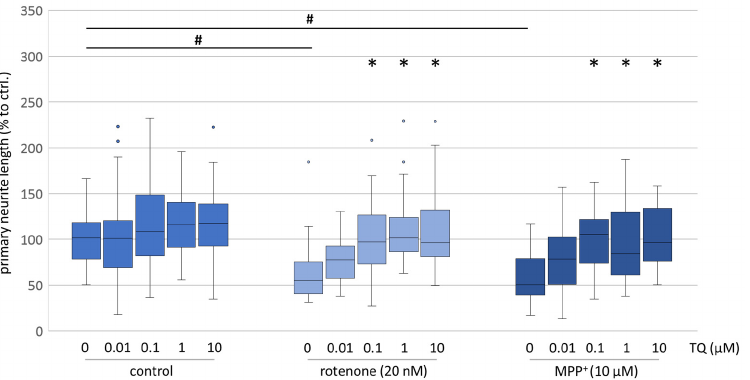
Figure 3. Effects of TQ on the length of the primary neurites of THir (dopaminergic) neurons in rotenone- or MPP + -affected primary mesencephalic cultures after 48 h treatment. Specifically, 100% corresponds to the number of dopaminergic neurons in the untreated controls (0 µM TQ, 0 nM rotenone, 0 µM MPP + ). The data represent at least three independent experiments. Statistically significant differences between the TQ groups and the respective controls were determined using the Kruskal–Wallis (H) test followed by the χ 2 test (* p < 0.05). The Mann–Whitney (U) test was used to evaluate the effects of the rotenone/MPP + vs. the control (# p < 0.05).